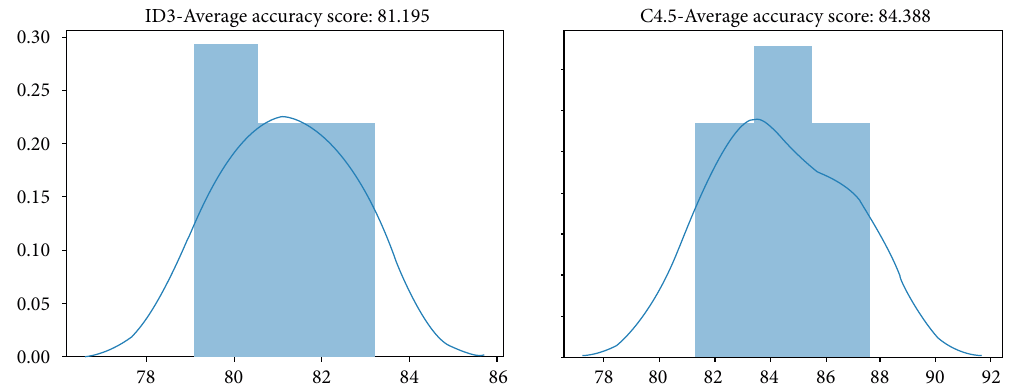
Figure 7: The average accuracy score of ID3 and CD4.5 for focused course classification problem.